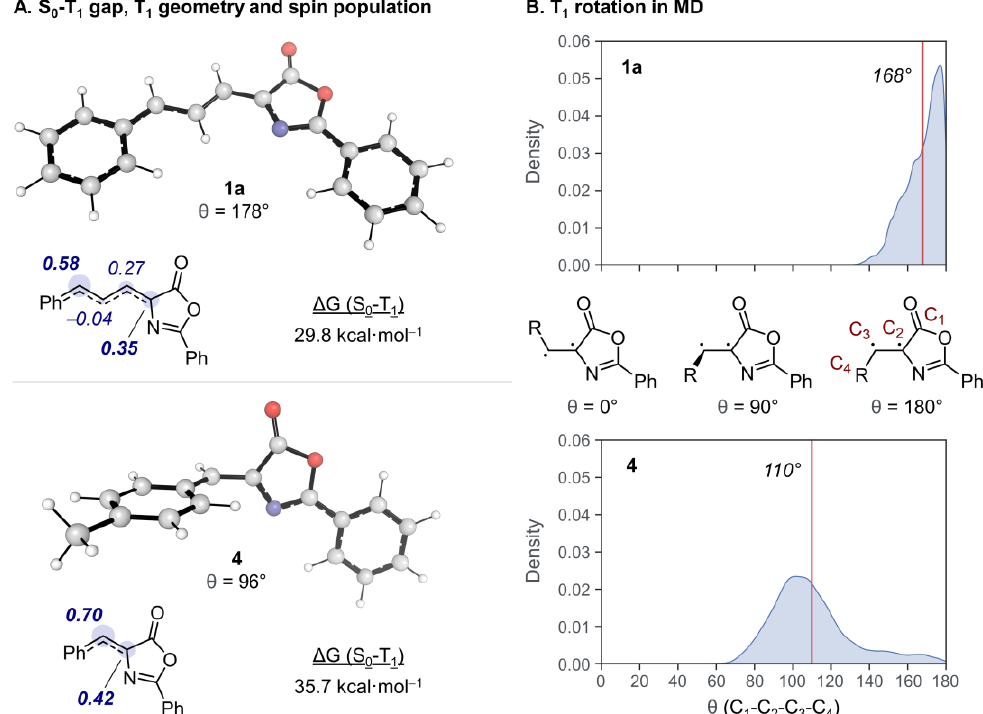
Figure 11. ( A ) G difference between optimized geometries of 1a and 4 in S 0 and T 1 , along with natural spin populations [63] of their conjugated systems and representations of T 1 geometries . ( B ) Dis- tribution of the θ dihedral angle from MD simulations of 1a and 4 in T 1 . Since rotations were sym- metrical in both directions, any values above 180° were converted to their equivalent degrees be- tween 0 and 180° for clarity (i.e., 190° would be equivalent to 170°).